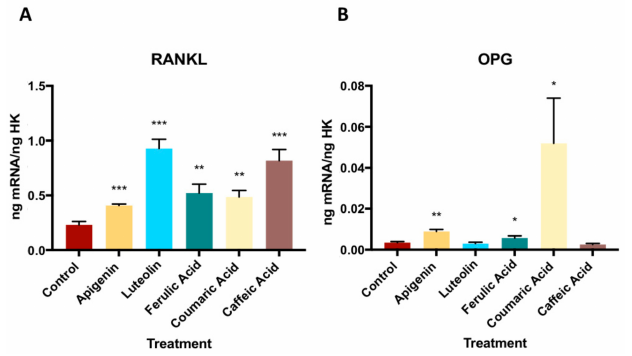
Figure 3. The effect of phenolic compounds on gene expression of OPG-RANKL complex. * p < 0.05, ** p < 0.005, *** p < 0.001. OPG- RANKL: Osteoprotegerin- receptor activator of nuclear factor-kappaB ligand.